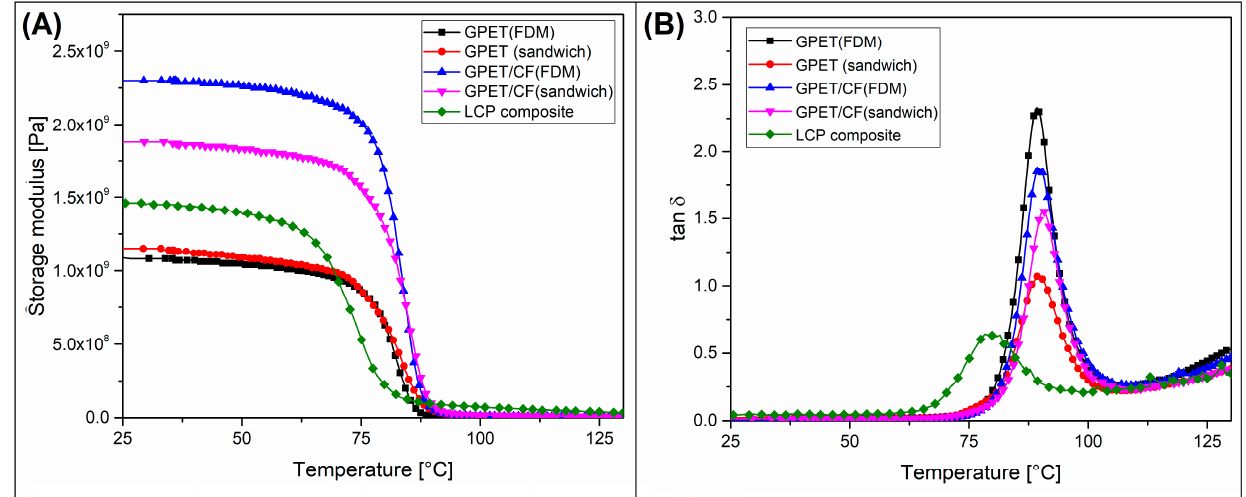
Figure 4. Storage modulus ( A ) and tan δ ( B ) thermograms for different types of samples.